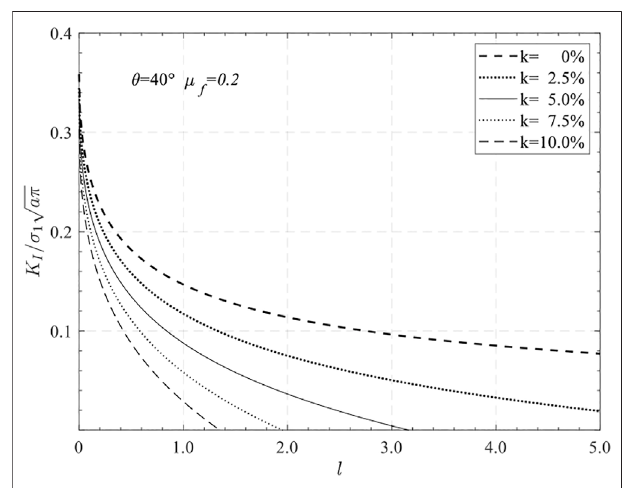
FIGURE 4 | SIF as a function of l and k ( μ f = 0.2, θ = 50 ° , k = σ 3 / σ 1